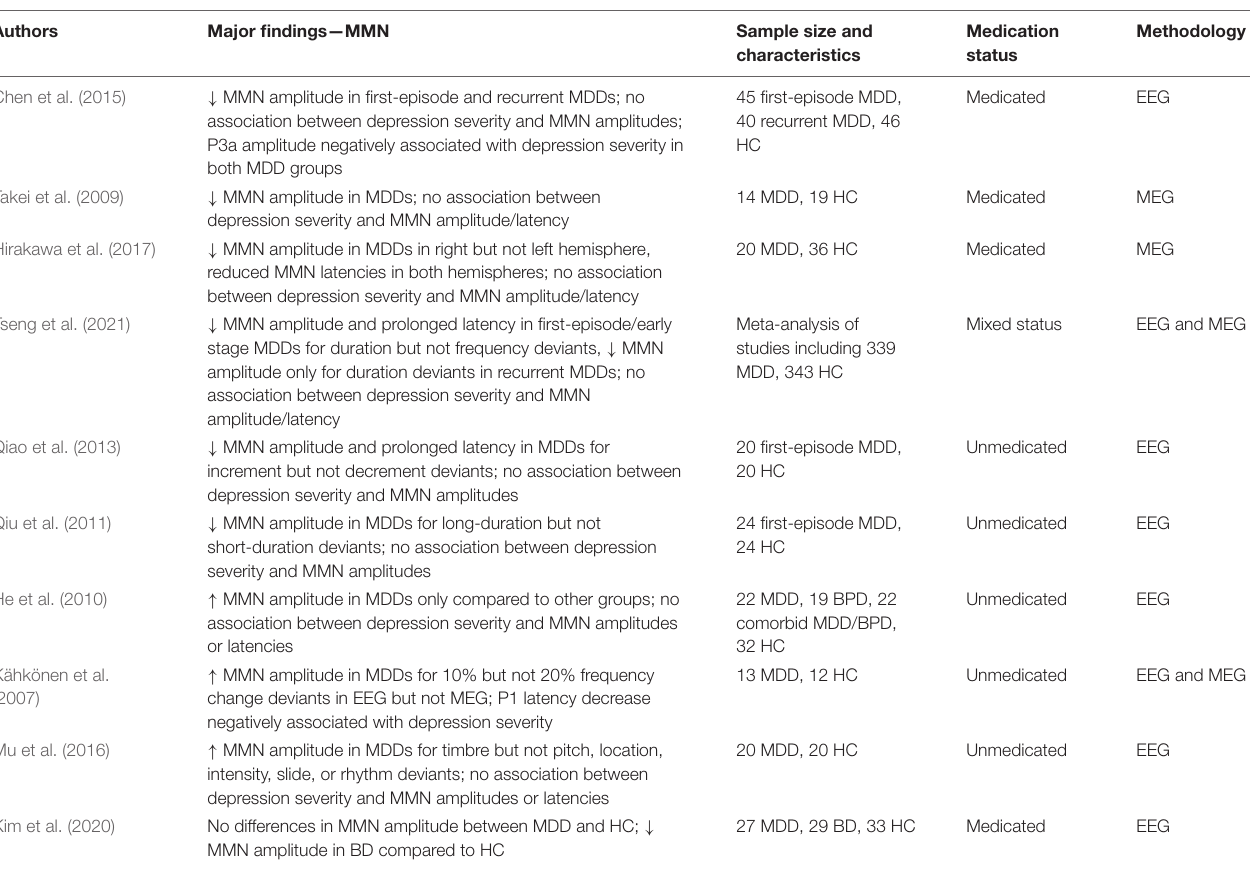
TABLE 1 | Sensory deviance detection disruptions in